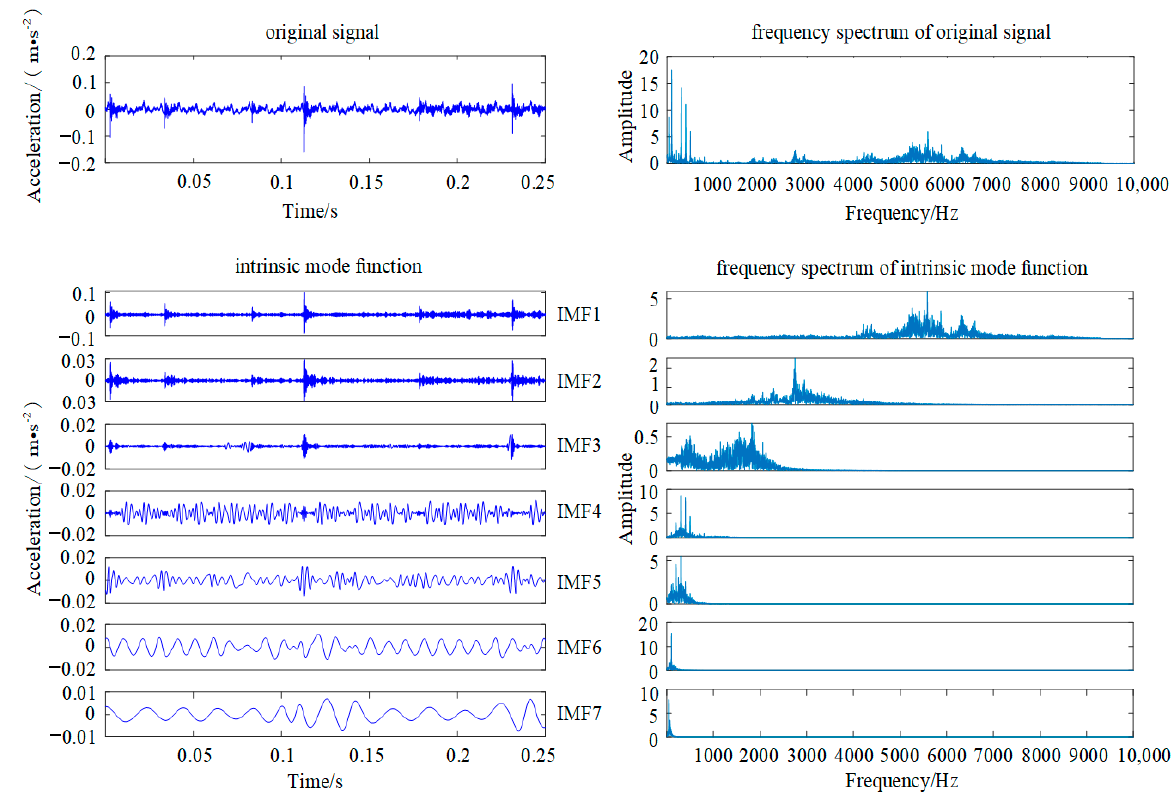
Figure 6. EMD decomposition diagram.